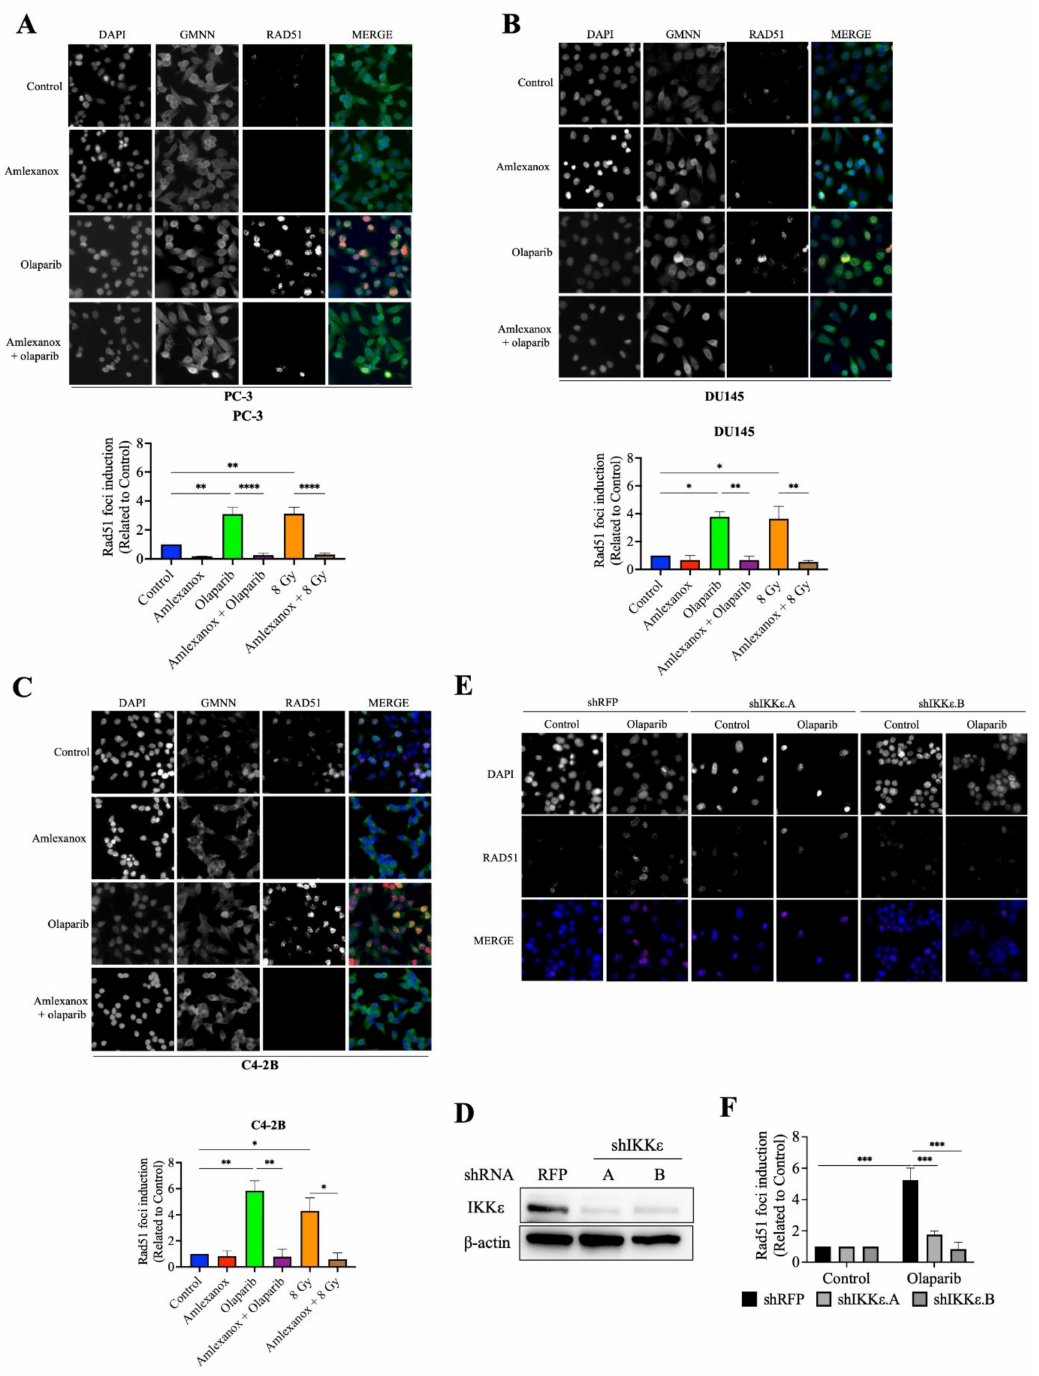
Figure 3. Amlexanox inhibits Olaparib-induced Rad51 recruitment. ( A – C ) Representative images and quantification of Rad51 foci in CRPC cells treated with 100 µ M Amlexanox (48 h) and/or 10 µ M Olaparib (for 24 h). Cells were fixed and stained for Rad51 foci (red), GMNN (green) and DAPI (blue). Pictures were taken using a Zeiss microscope and the number of Rad51 foci per GMNN-positive cells were counted using ImageJ. ( D ) PC-3 cells were transfected with lentiviral shIKK ε .A or shIKK ε .B. Western blots confirmed IKK ε depletion with whole cell extracts separated, transferred and probed with IKK ε antibody. ( E ) Representative images and ( F ) quantification of Rad51 foci in IKK ε -depleted PC-3 cells. Each experiment was repeated three times. Statistical significance was determined by two-way ANOVA. * p < 0.05; ** p < 0.001; *** p < 0.0001; **** p < 0.00001. The full Western blots are shown in Figure